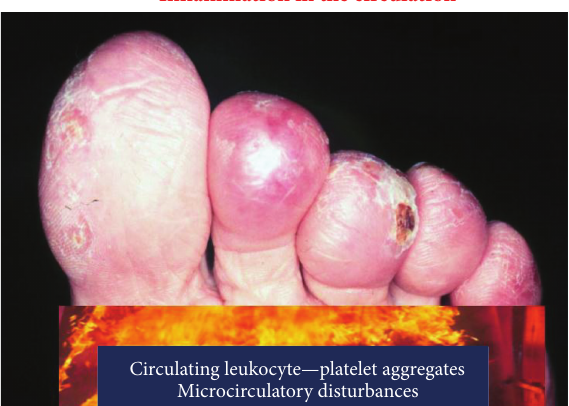
Figure 5: Inflammation in the circulation elicits in vivo leukocyte and platelet aggregation giving rise to circulating microaggregates with ensuing impairment of microcirculation, tissue ischemia, and ultimately development of ulcers on toes and fingers which may terminate with gangrene. Treatment with aspirin momentarily resolves microaggregation with improvement in